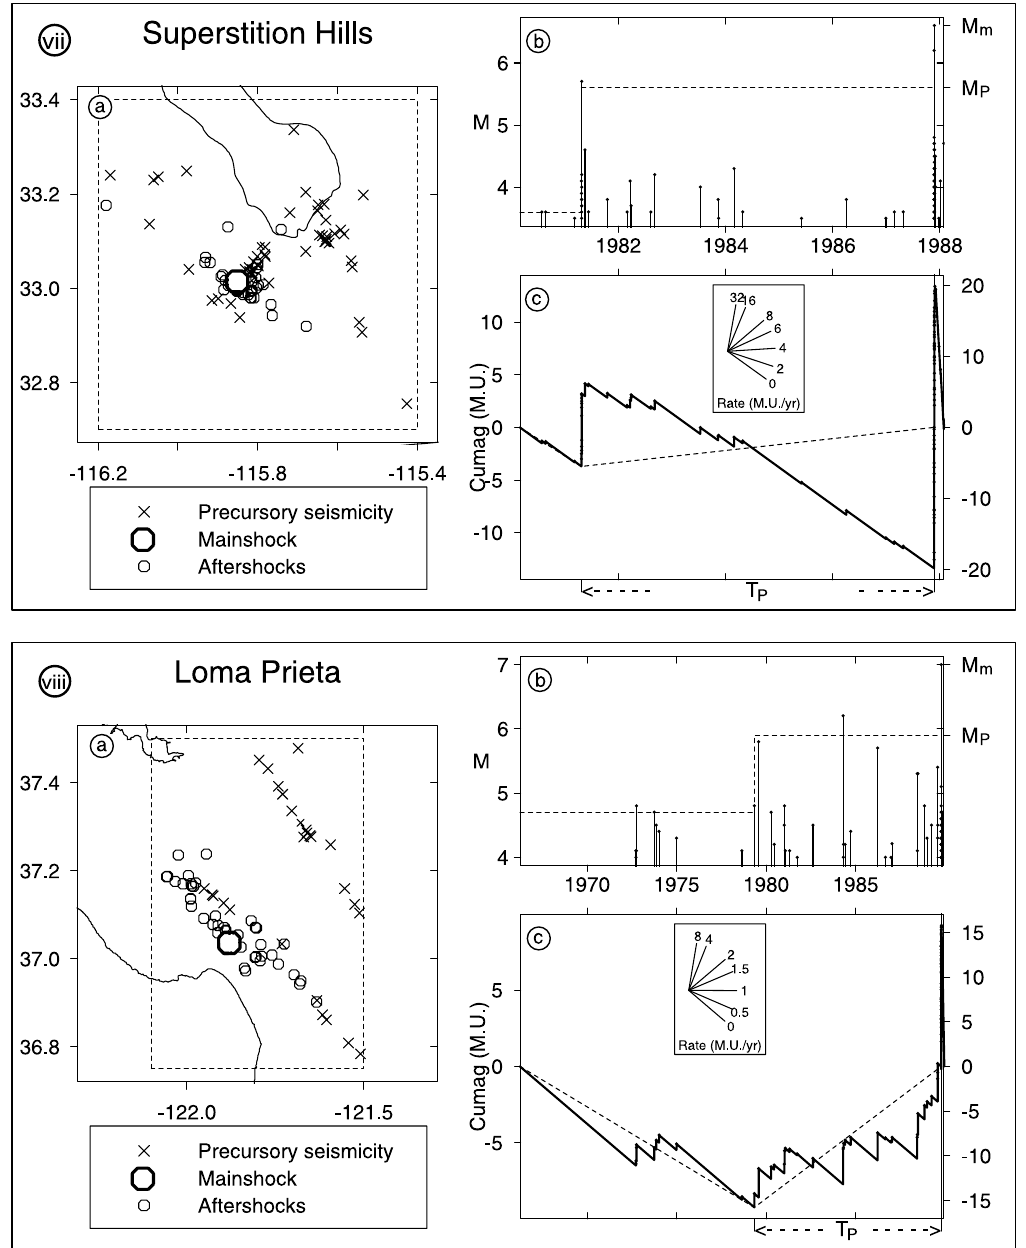
Fig. 3vii,viii. (cid:115) -phenomenon: data and interpretation for major earthquakes at (vii) Superstition Hills and (viii) Loma Prieta. For explanation see caption fig.